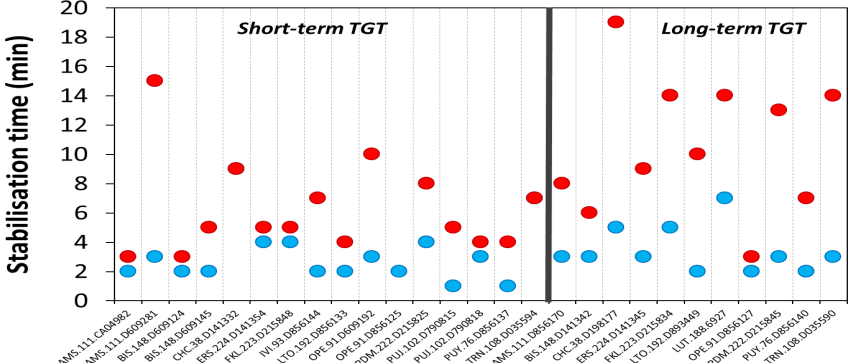
Figure 4. Average stabilization times (in minutes) estimated to have a difference from the last minute of the target gas measurement of less than ± 0.05µmolmol − 1 for CO 2 (in red) and ± 1nmolmol − 1 for CH 4 (in blue). The time is calculated for several instruments indicated on the x axis; the left side of the figure shows short-term target gas measurements, whereas the right side shows the long-term target measurements, which are less